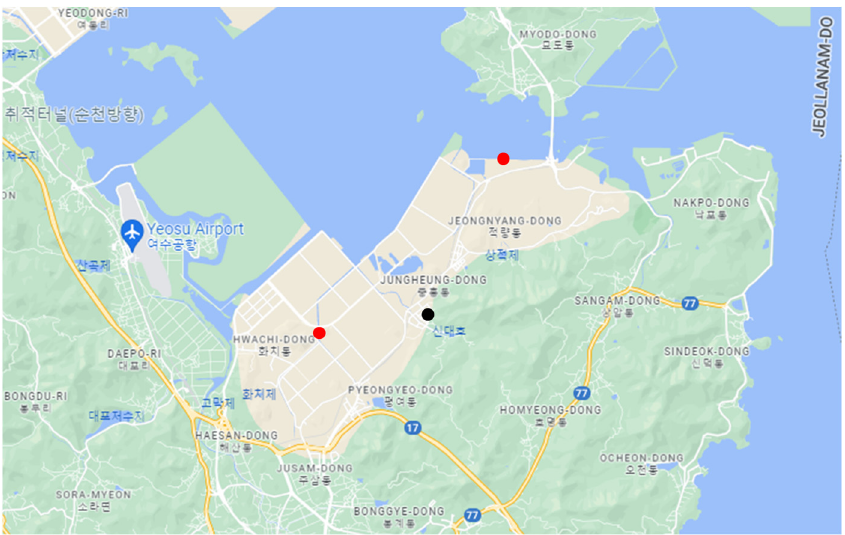
Figure 5. Location of the tower (red dot) and central control room (black dot). (Source: Google maps). Table 2. Design characteristics of the steel